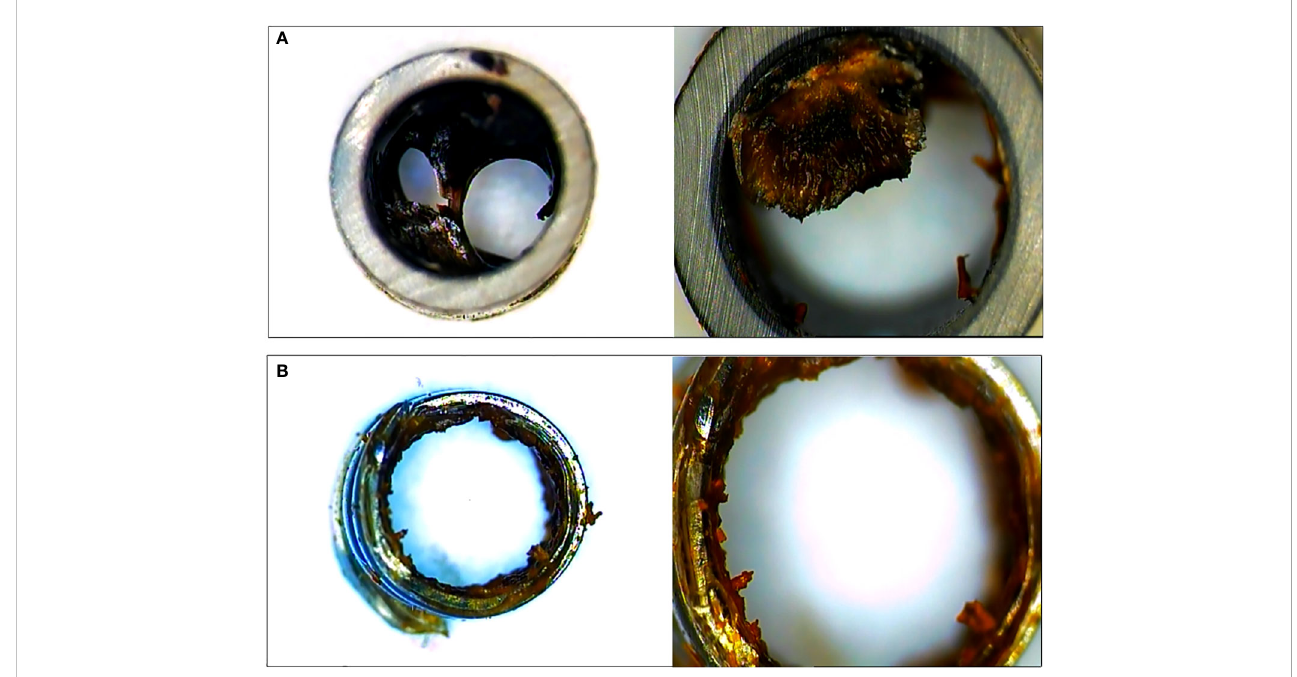
FIGURE 4 The cross section of plastic stent (A) and novel biliary metal stent (B) were checked after endoscopic stent removal. Both stents had been placed for 4 weeks. Novel biliary metal stent showed a large inner diameter through less formation of bio fi lm and biliary